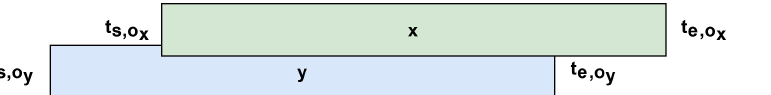
Figure 2. An example of a resource access conflict, where the technological operation x started before the end of the technological operation y